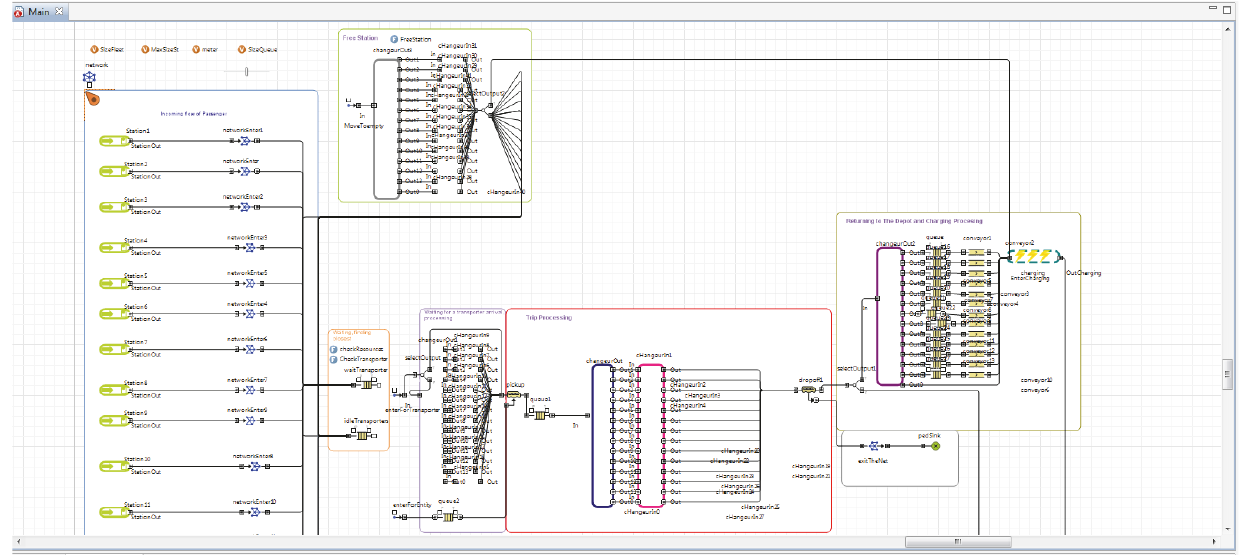
Figure 10: Simulation